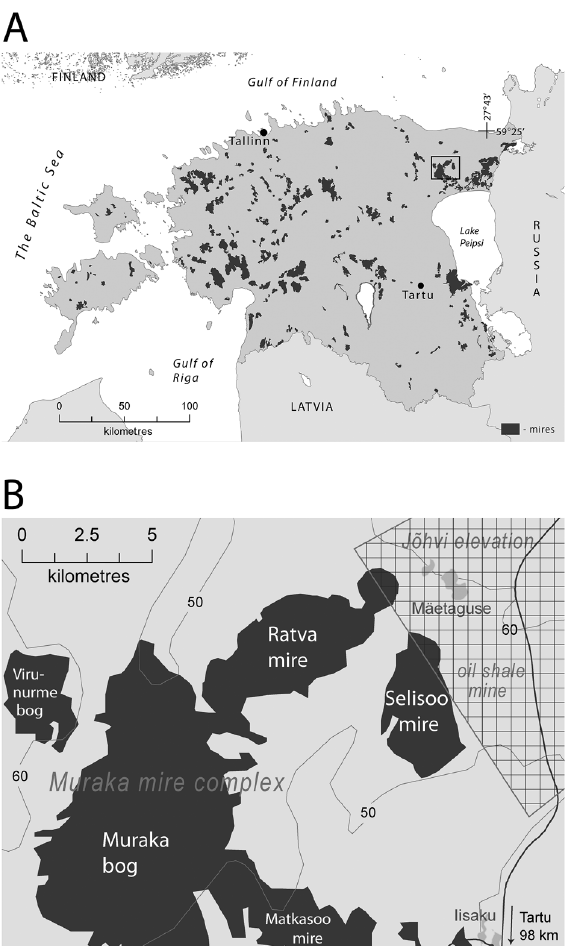
Fig. 1. ( A ) Large mires in Estonia (Allikvee & Ilomets 1995) and the location of the Selisoo mire. ( B ) The Jıhvi elevation extends to the northern limit of the mire. The underground oil shale mine is approaching the Selisoo mire from the east. The area covered by mining permit, marked with a rectangular grid, extends below the